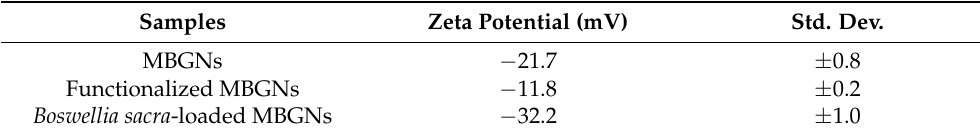
Table 3. Zeta potential of MBGNs before and after loading of Boswellia sacra extract. Samples Zeta Potential (mV) Std.